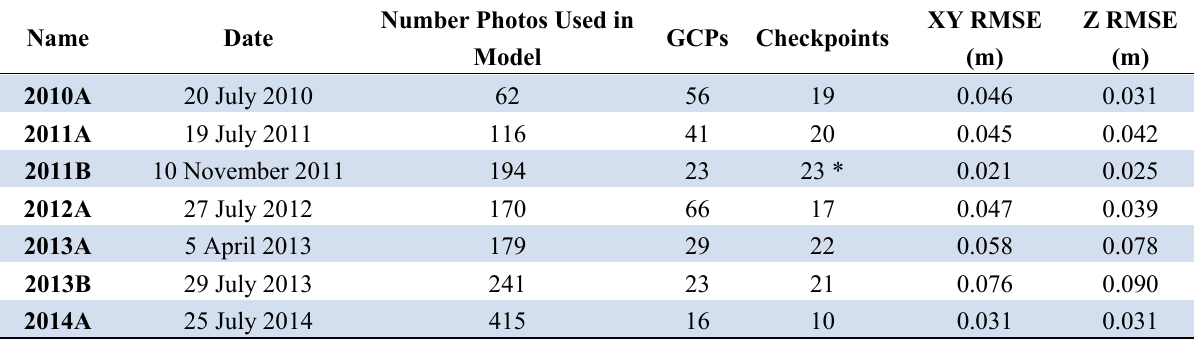
Table 3. Summary of spatial errors for Home Hill landslide DSMs and